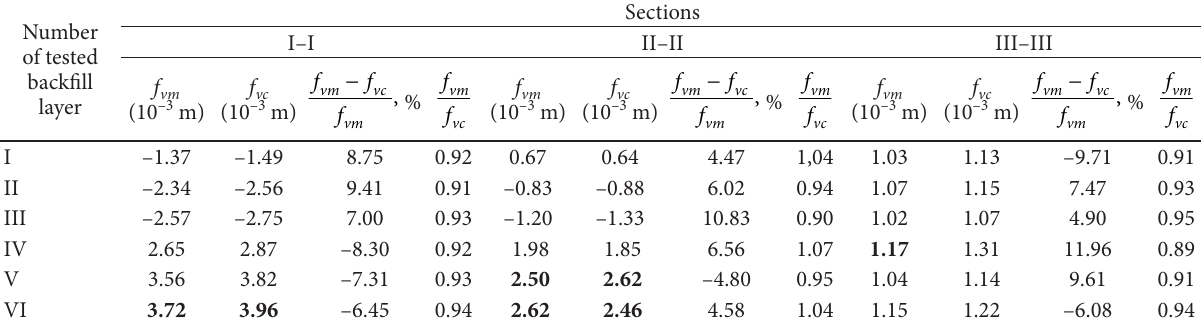
Table 1. The values of max vertical displacements received from measurements and calculations (10 -3 m) in steel shell structure in analysed sections during the soil compaction Number of tested backfill layer